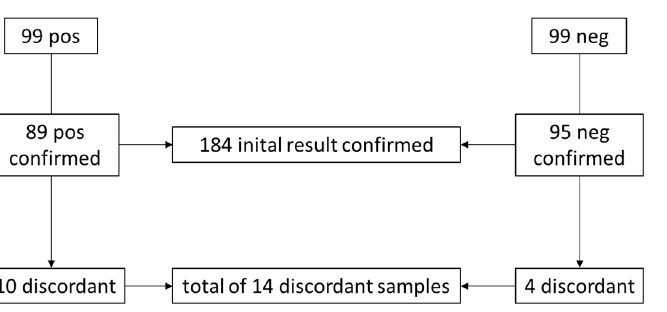
Figure 1. Concordance analysis of qualitative results in 99 positive and 99 negative samples of the inter-laboratory comparison. Samples were classified as discordant if at least one of the comparison assays did not confirm the initial result obtained with the QIAGEN test.